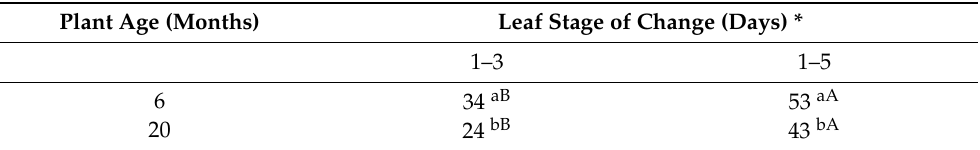
Table 5. Average period (days) of leaf differentiation of growth stages 1 to 3 and 1 to 5 of Eucalyptus grandis plants of 6 and 20 months old. Plant Age (Months) Leaf Stage of Change (Days) *